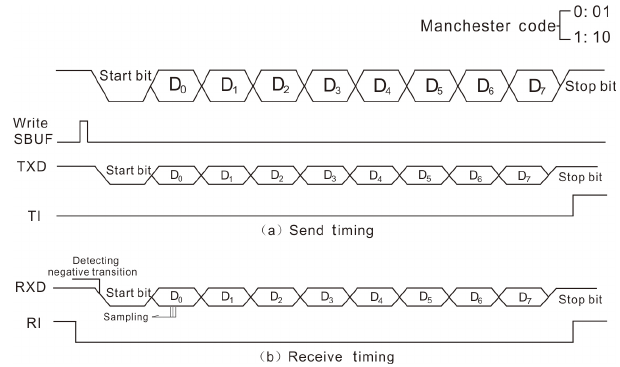
Figure 5. Superposition of Manchester encoding data-transmission sequence